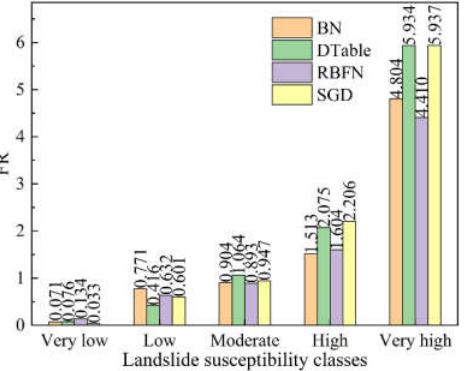
Figure 9. Frequency ratio of landslides within susceptibility classes.